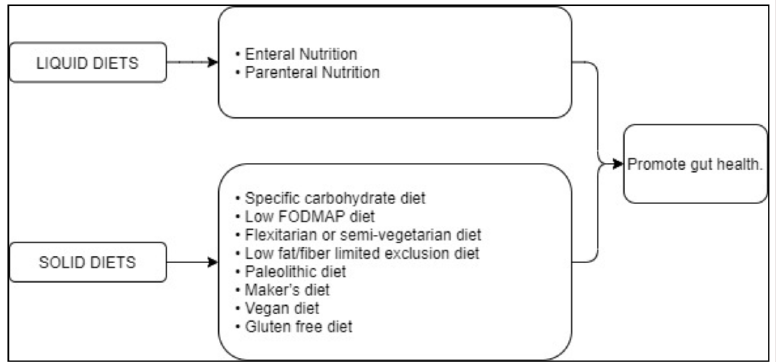
Figure 1. Synoptic view summarizing the different dietary regimens for the treatment of